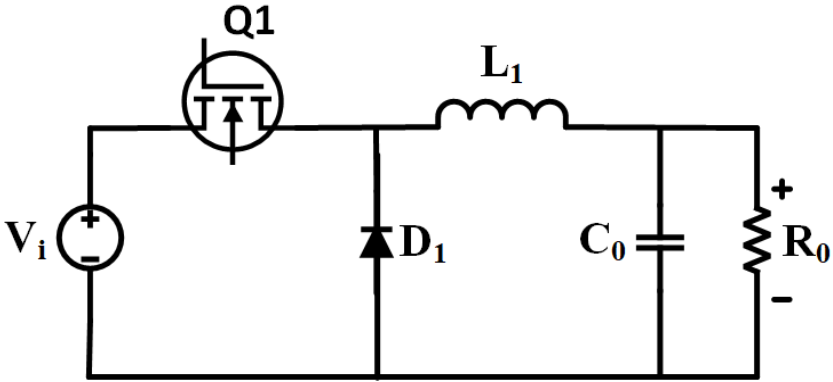
Figure 6. DC-DC buck converter.